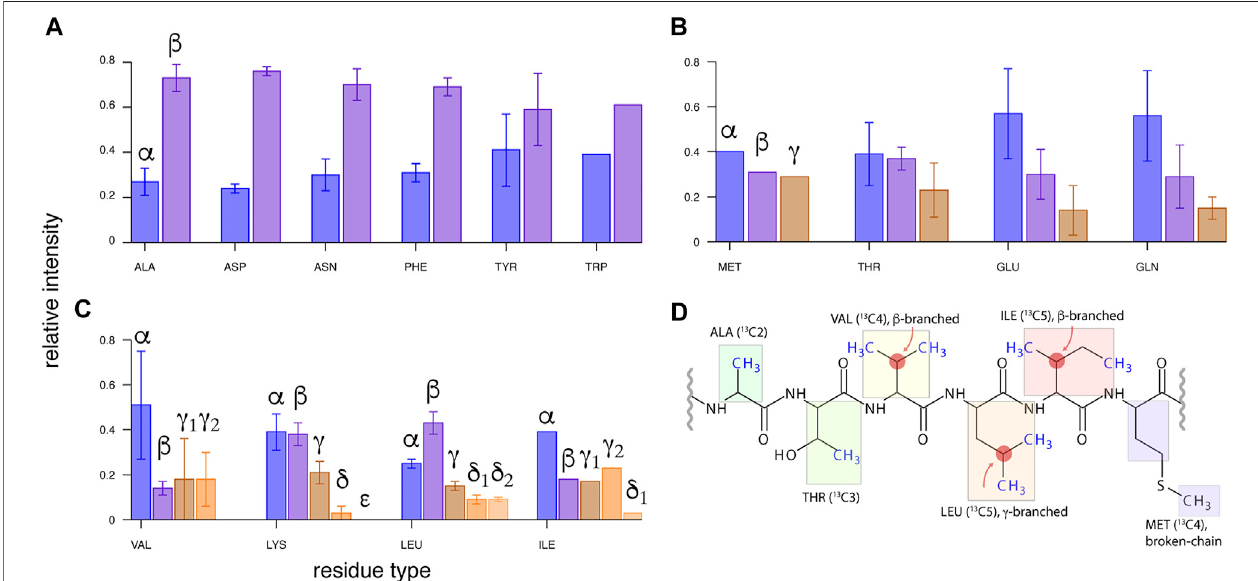
FIGURE 1 | Transfer ef fi ciencies from side-chain 13 C ( β , γ , ... ) to 13 C α spin for various residues in microcrystalline U- 13 C, 15 N-labeled GB1 protein using 13 C WALTZ-16 mixing of 15 ms duration, with MAS of ν R = 111 kHz (in a 0.7-mm rotor) and on a 23.5-T spectrometer. Intensity of 13 C X - 13 C α - 1 H α cross-peaks in (H)CCH spectrum(Andreas etal.,2016;Staneketal.,2016)wasnormalizedtoasumof1.0foreach residue, andaveragedwithineachaminoacidtype.Thedataweregrouped into (A) two- and pseudo-two-, (B) three- and pseudo-three-, and (C) four- and fi ve-aliphatic 13 C spin systems (disregarding backbone and side-chain carbonyl and aromatic 13 C spins). (D) Topologies of 13 C side chains for six amino acid residue types containing a methyl group, from left to right: least to most challenging for methyl resonance